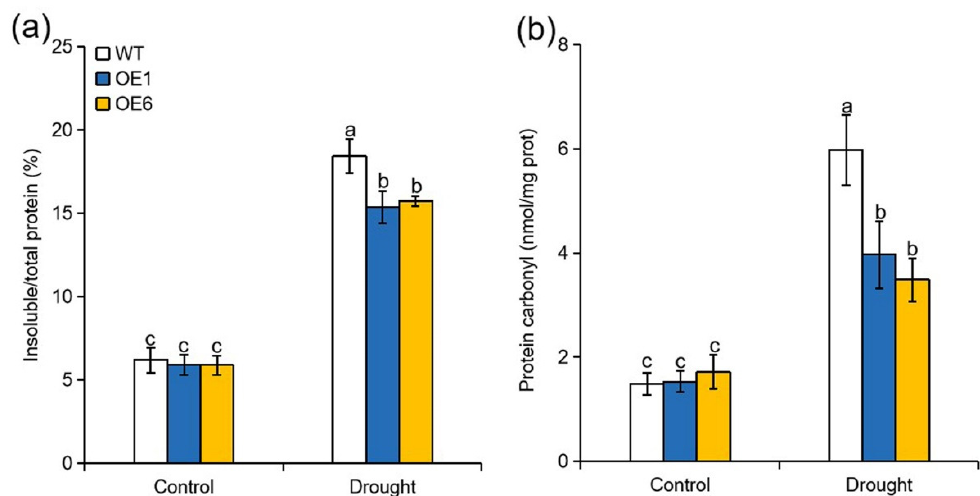
Figure 4. Effect of MdATG8i overexpression in apple on the accumulation of insoluble and oxidized proteins under drought conditions. ( a ) Percentage of insoluble proteins relative to total proteins and ( b ) levels of oxidized proteins in WT and MdATG8i OE plants. The data are presented as means ± SD of three replicates. Values with different letters are significantly different ( p < 0.05, Tukey’s multiple range test).